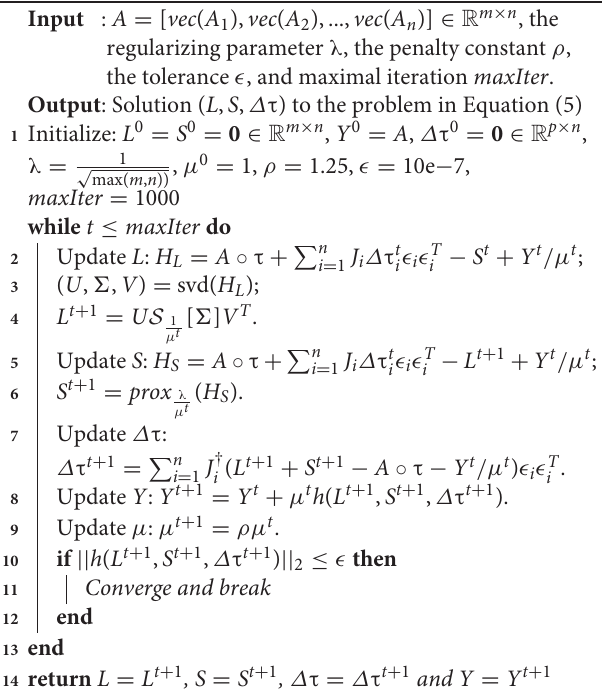
Algorithm 1: Transformed Low-Rank and Structured Sparse Decomposition (TLS 2 D)